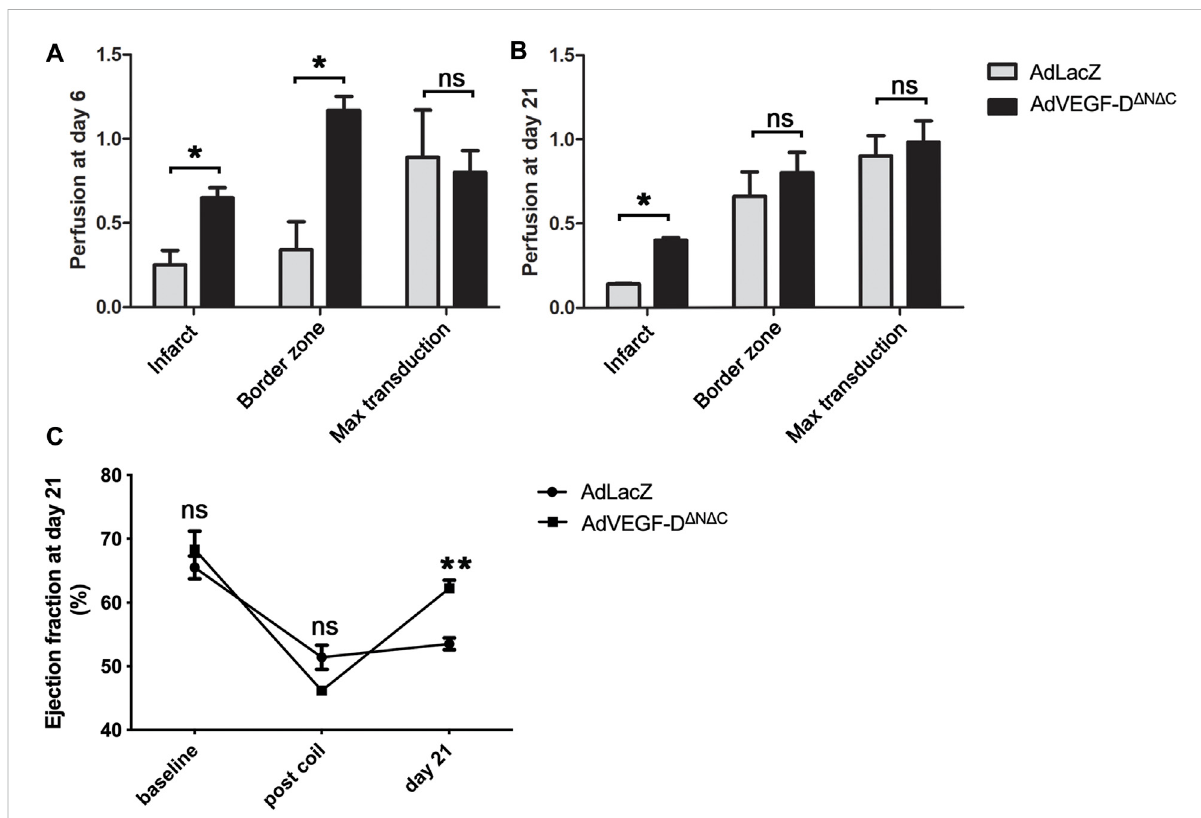
FIGURE 5 AdVEGF-D Δ N Δ C increases perfusion and ejection fraction. (A) At day 6 AdVEGF-D Δ N Δ C increased perfusion in the infarct and in the infarct border zone compared to AdLacZ. (B) At day 21 slight increase in perfusion was still observed. (C) At day 21 echocardiography showed a statistically signi fi cant increase in ejection fraction in the AdVEGF-D Δ N Δ C group. ns = non-signi fi cant ( p > 0.05). * = p < 0.05. ** = p < 0.01. Figures A and B show mean perfusion ratios to control area with standard errors.